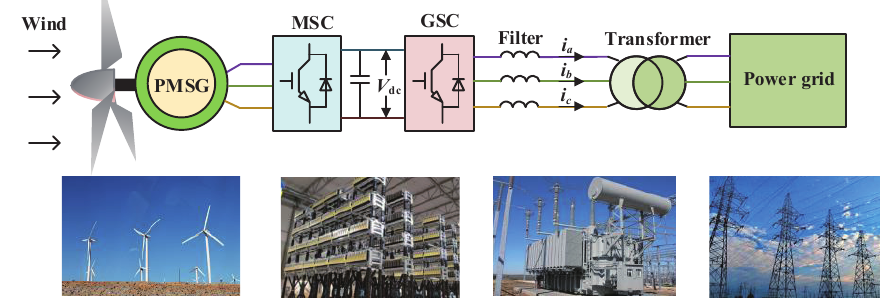
Figure 2. Configuration of a